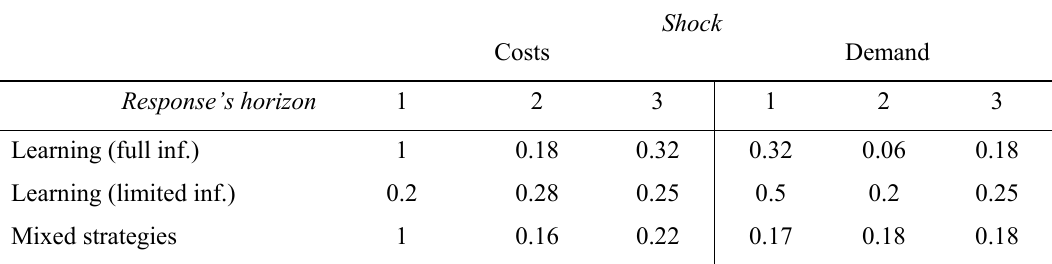
Table 7 . Rejection rates for impulse-response